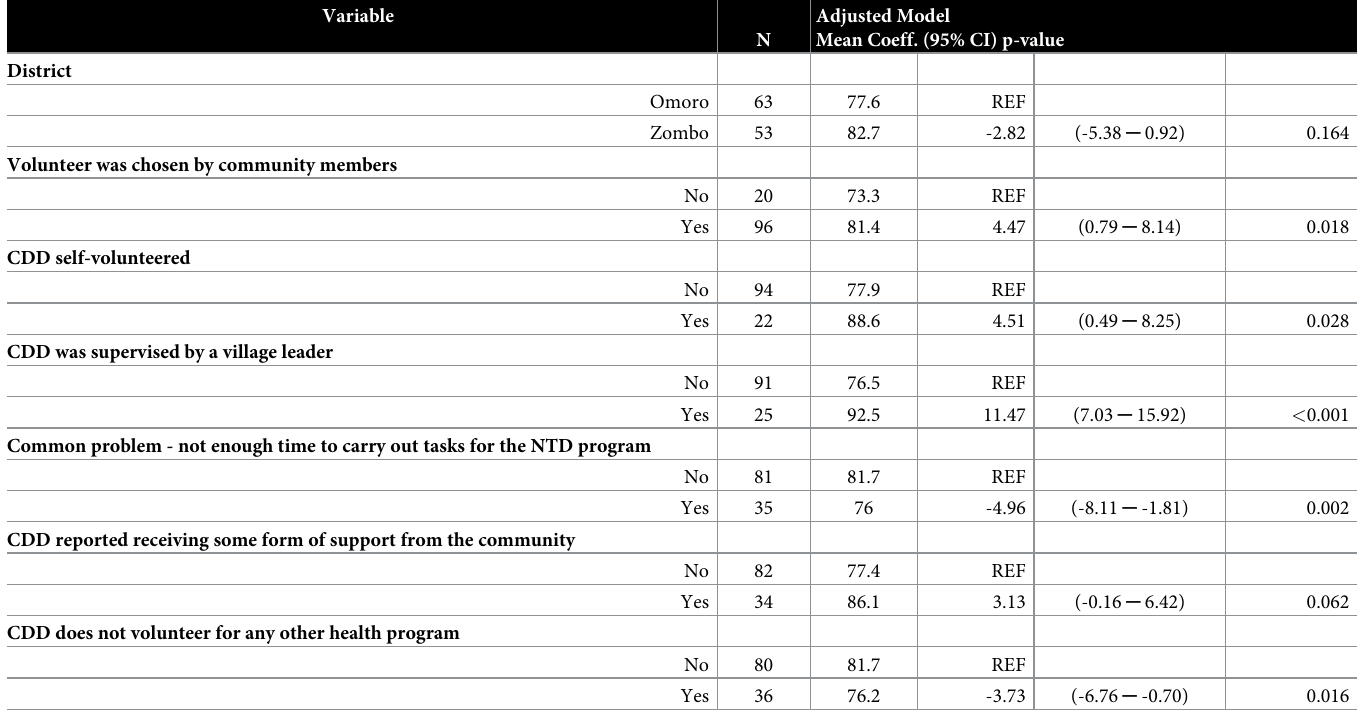
Table 12. Correlates of CD-RISC-25 scores for CDDs volunteering in MDA programs in